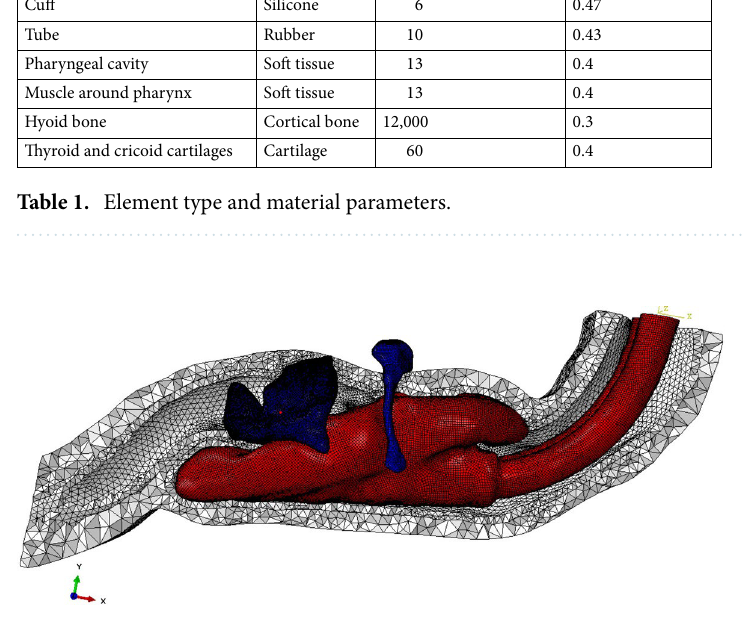
Figure 4. The inserted LMA is divided into shell elements, and PBs are divided into tetrahedron elements.